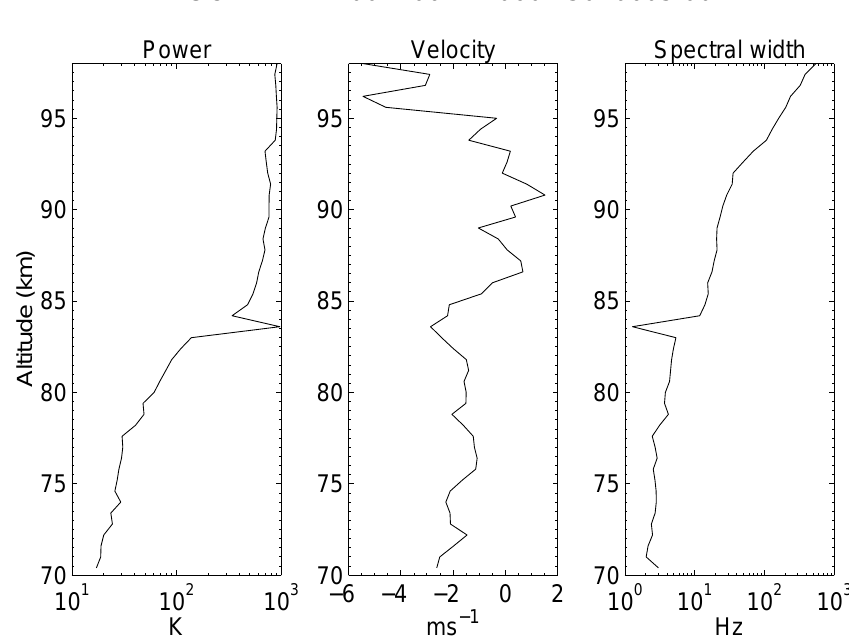
Fig. 6. Example data measured in Tromsø by EISCAT VHF radar at 224MHz. Antenna pointing is vertical. The received power is expressed as a noise temperature in Kelvin, Doppler velocity in ms − 1 and spectral width in Hz. Positive velocity means velocity is upwards. All three modes of lag profiles are used everywhere in the fitting and a Lorentzian shape of spectrum is assumed, which means that E-layer altitudes are not included in the analysis. Integration time is two and one-half minutes. Polar Mesospheric Summer Echo at 83.6km altitude is seen in all measured